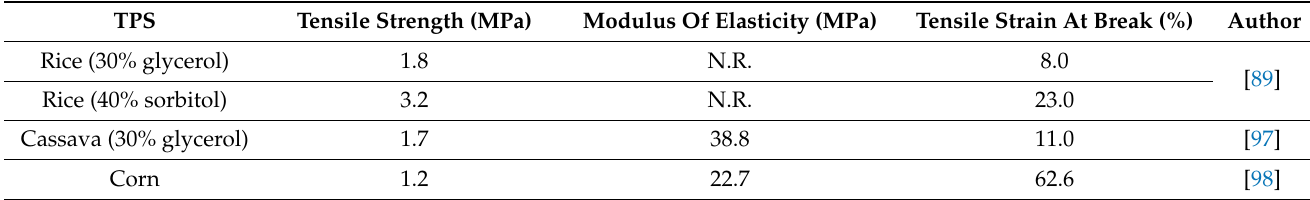
Table 6. Tensile properties of thermoplastic